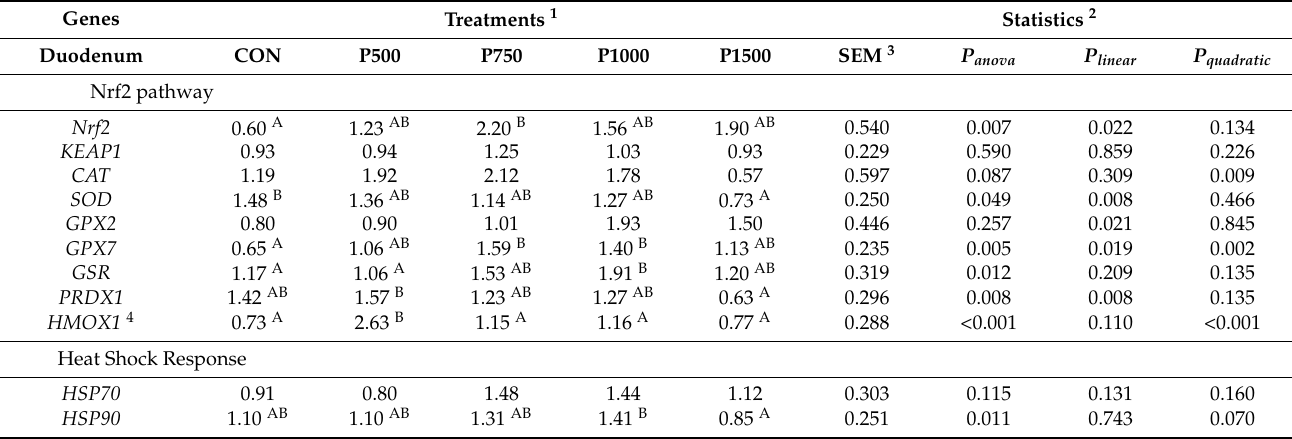
Table 6. Relative expression of Nrf2 pathway genes and heat shock response-related genes in the layers’ duodenum at 8th week of the experiment.